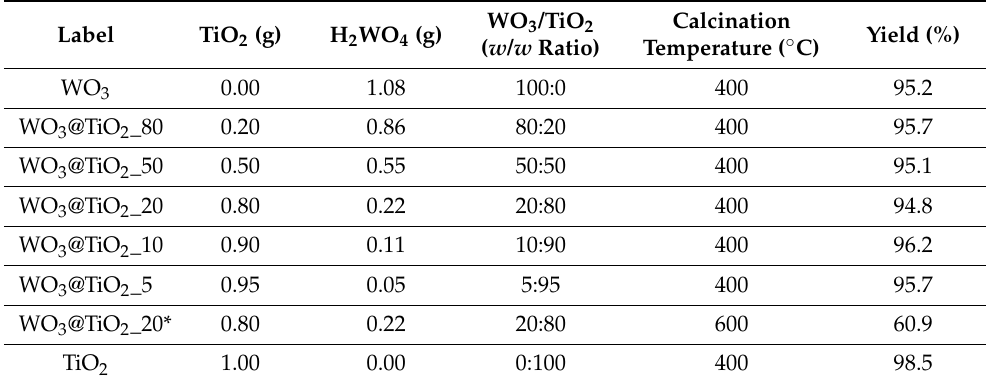
Table 2. Labels of the WO 3 /TiO 2 composites, WO 3 /TiO 2 w / w ratio, calcination temperature, and reaction